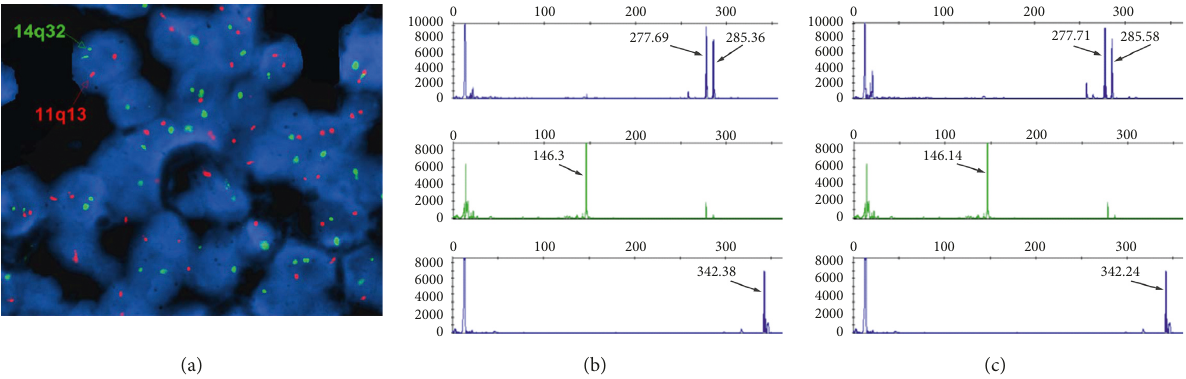
Figure 3: Case 1: FISH studies for IgH - CCND1 fusion were negative (a). This assay was repeated in a reference lab and was again negative. PCR analysis was performed in the original splenic marginal zone lymphoma (b), and in the relapsed lymphoma (lymph node, and clonal PCR amplification products (c) were compared. Amplification products of the same size in base pairs in the initial and relapsed lymphomas were present, supporting that the tumors were clonally